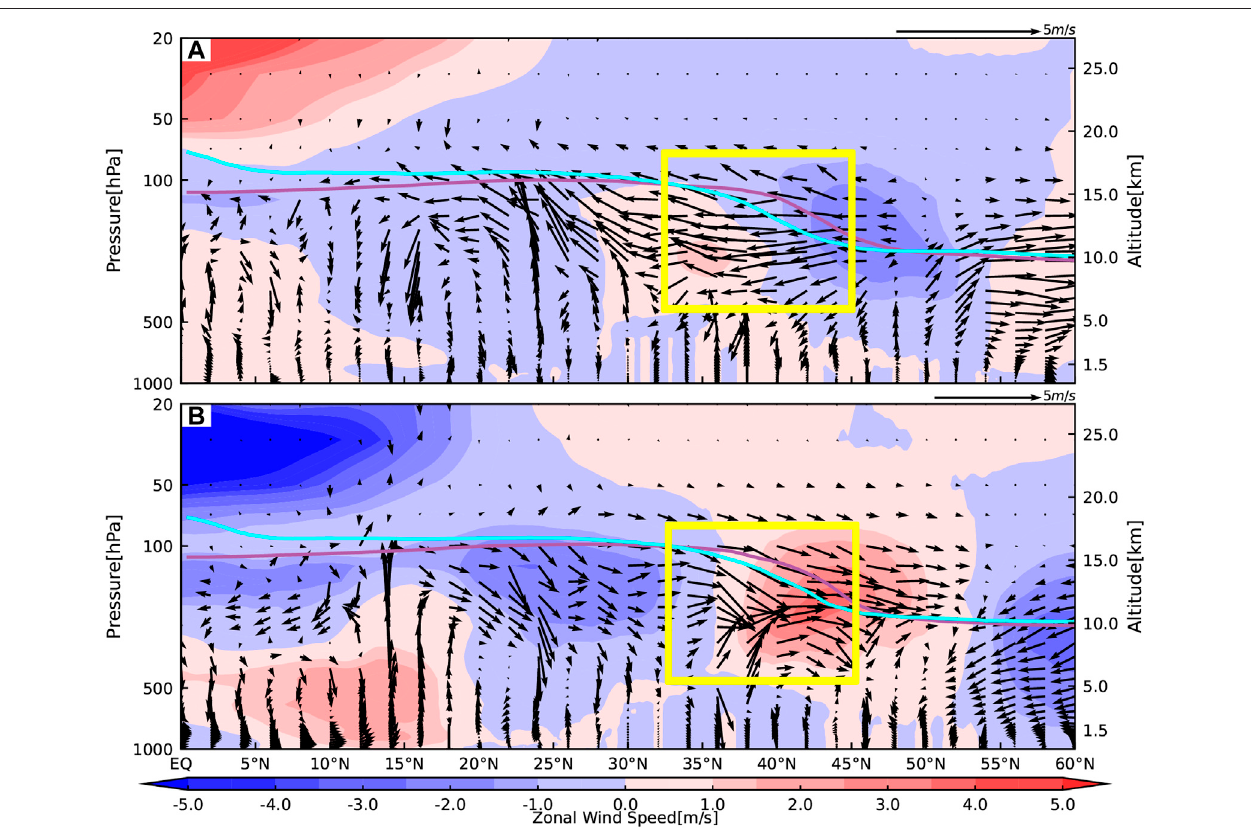
FIGURE14| Theheight – latitudecross-sectionsofthecompositewind fi eld(arrows,unit:m/s)along95 ° EfortheEOFtimeseries3inthe (A) strongeryearsand (B) weaker years. Here, the vertical wind speed anomaly is fi ve times of the original wind fi eld. The shadows denote the zonal wind. The purple lines are the height of the thermal tropopause and the blue lines are the height of the dynamical